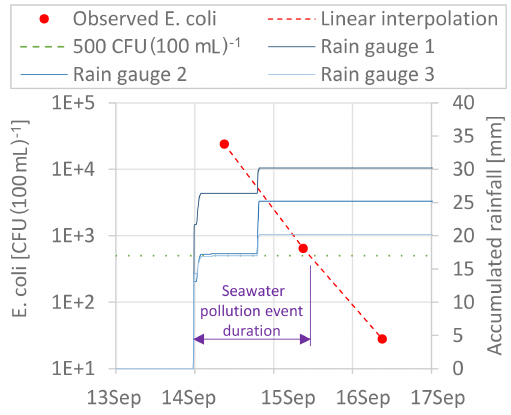
Figure 11. Example of how the duration of a seawater pollution event was graphically